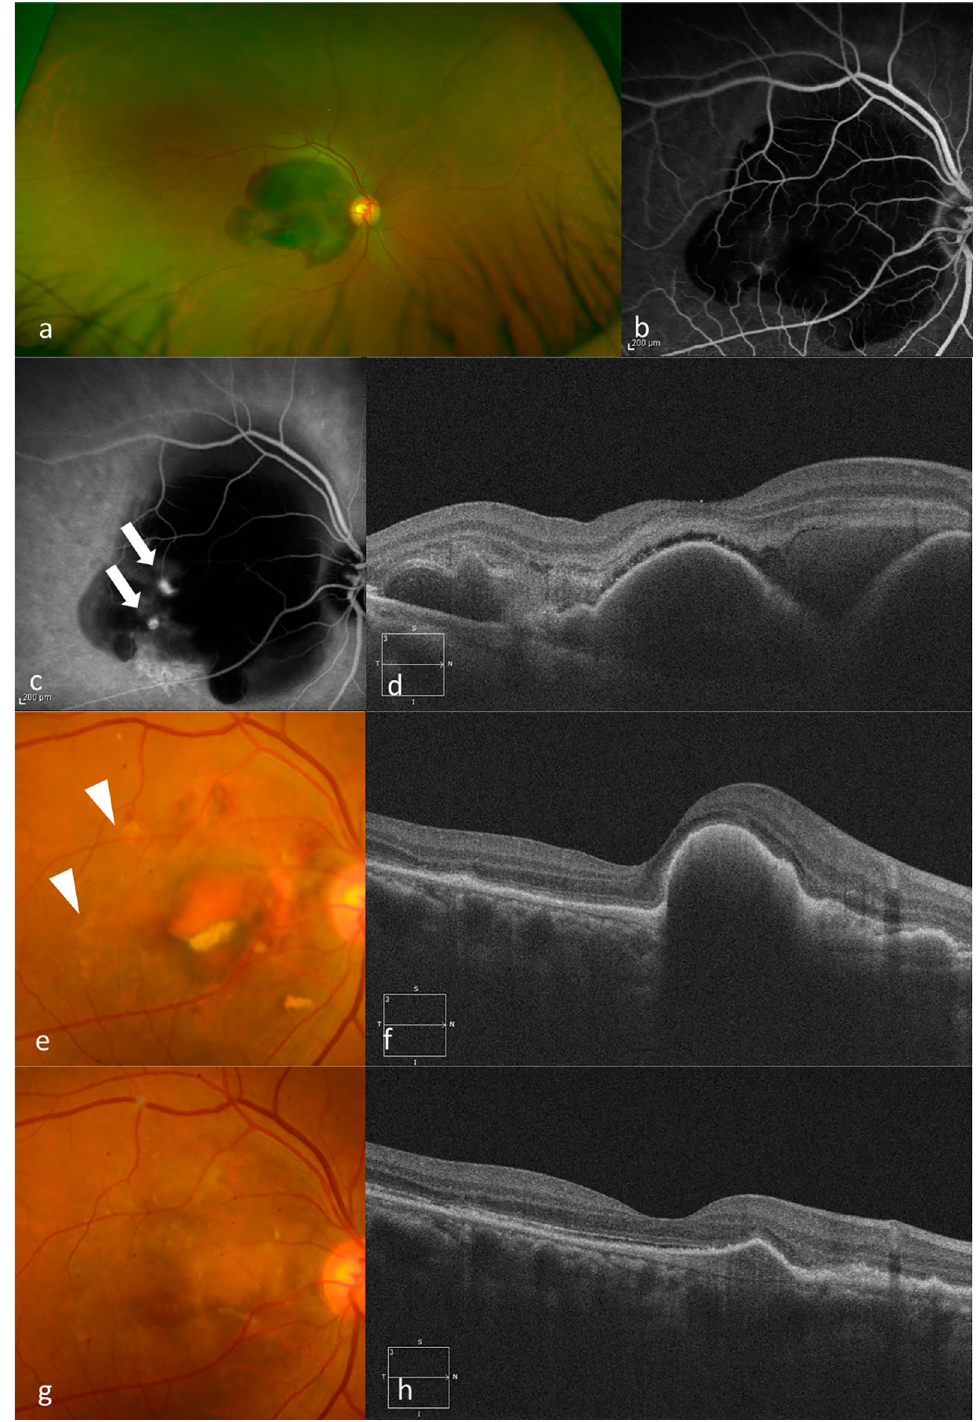
Figure 3. ( a ) A 60-years-old woman presented with sudden visual loss in her right eye (BCVA 20/30). Funduscopic examination in that eye shows a SMH in the macula. ( b ) Fluorescein angiography shows blockage due to the hemorrhage. ( c ) Indocyanine green angiography shows a polypoidal lesion and an abnormal vascular network (arrows). ( d ) A baseline OCT image shows a SMH and hemorrhagic PED. She was diagnosed PCV and received IVA treatment monthly during the loading phase. ( e ) Fundus photography at 3 months shows that the SMH resolved. Hyperpigmented spots are noted (arrowheads). ( f ) OCT at 3 months still shows a hemorrhagic PED. ( g ) Fundus photography at 1 year shows no SMH. Her BCVA improved to 20/20. ( h ) SD-OCT at 1 year shows improvement of the hemorrhagic